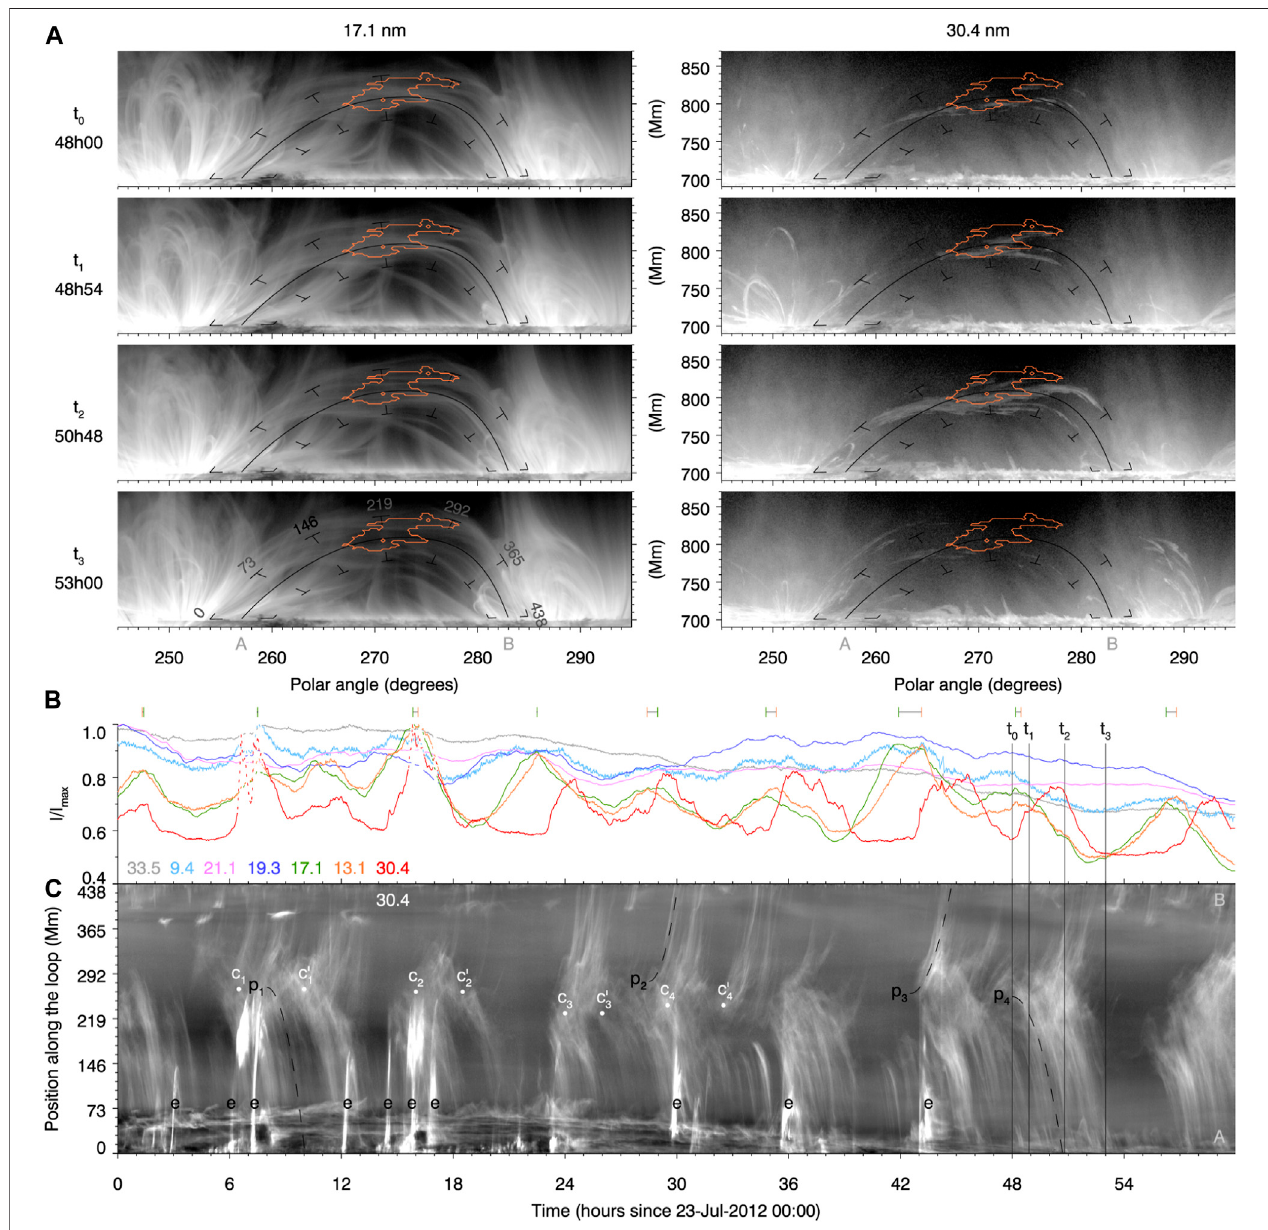
FIGURE 7 | Summary fi gure for the “ rain bow ” event of Auchère et al. (2018) (Figure 6 © AAS. Reproduced with permission). (A) illustrate the temporal evolution of the transequatorial loops studied in the 171 Å and 304 Å passbands of SDO /AIA. (B) shows the light curves in seven channels of SDO /AIA. These light curves are averagedovertheorangecontourpresentedinthetoppannels. (C) showstheintensityinthe304 Åchannelof SDO /AIA,alongthebundleofloopsasafunctionoftime. Periodic rain showers are seen in phase with the EUV pulsations. For details see Auchère et al. (2018).